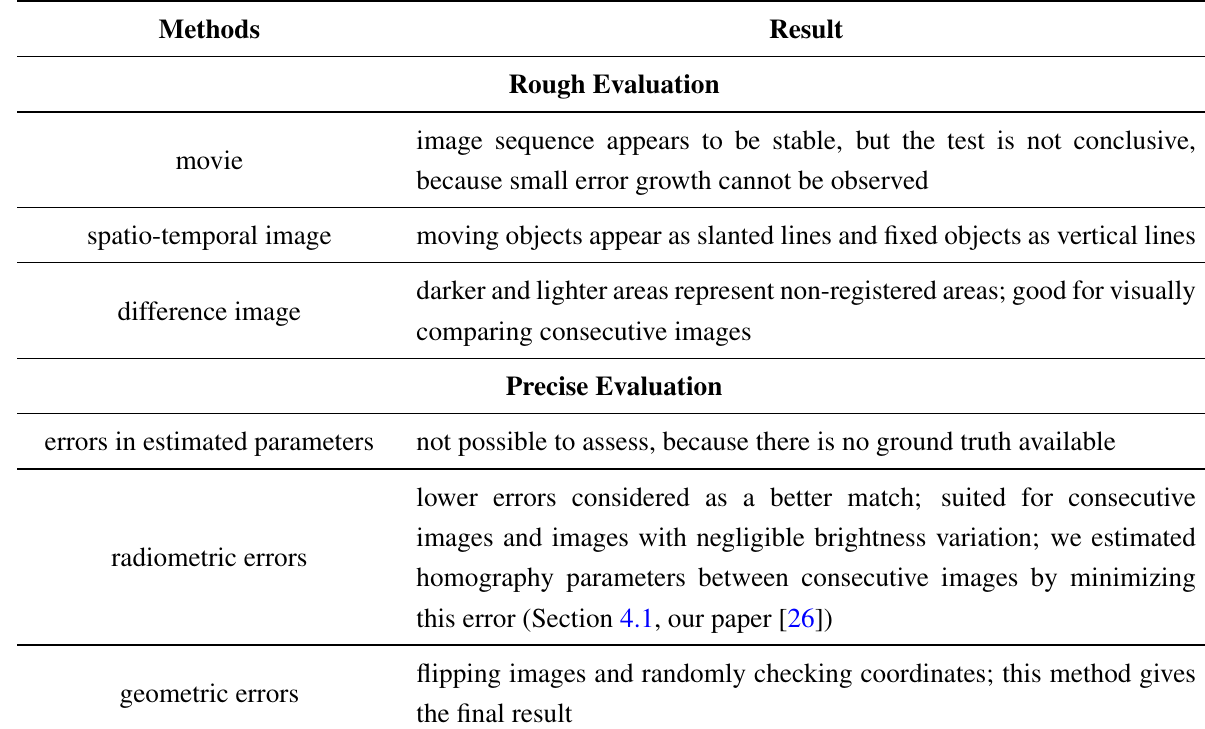
Table 2. Summary of the methods used to evaluate image-sequence